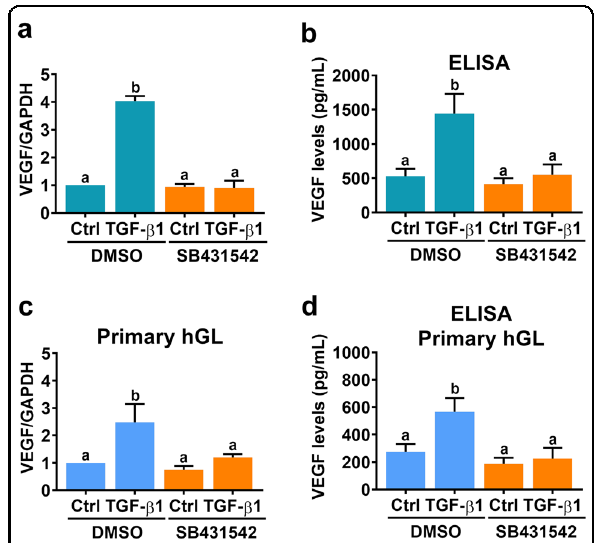
Fig. 2 Pharmacological inhibition of TGF- β receptor I blocks TGF- β 1-induced VEGF expression and secretion. a SVOG cells were pretreated with a vehicle control (DMSO) or 10 µM SB431542 for 1 h, and then they were treated with 5 ng/mL TGF- β 1 for 6 h. VEGF mRNA levels were examined by RT-qPCR. b SVOG cells were pretreated with a vehicle control (DMSO) or 10 µM SB431542 for 1 h, and then they were treated with 5 ng/mL TGF- β 1 for 24 h. VEGF protein levels in culture media were examined by ELISA. c Primary hGL cells were pretreated with a vehicle control (DMSO) or 10 µM SB431542 for 1 h, and then they were treated with 5 ng/mL TGF- β 1 for 6 h. VEGF mRNA levels were examined by RT-qPCR. d Primary hGL cells were pretreated with a vehicle control (DMSO) or 10 µM SB431542 for 1 h, and then they were treated with 5 ng/mL TGF- β 1 for 24 h. VEGF protein levels in culture media were examined by ELISA. The results are expressed as the mean ± SEM of at least three independent experiments. The values without a common letter are signi fi cantly different ( p <